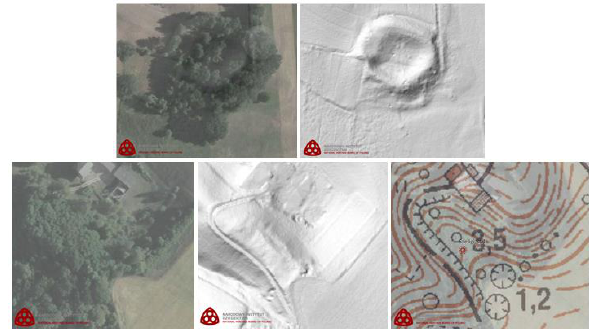
Fig. 3. Example of Slavic settlements presented with different data: orthoimage, DTM (shaded relief) and topographic map (source: NICH)